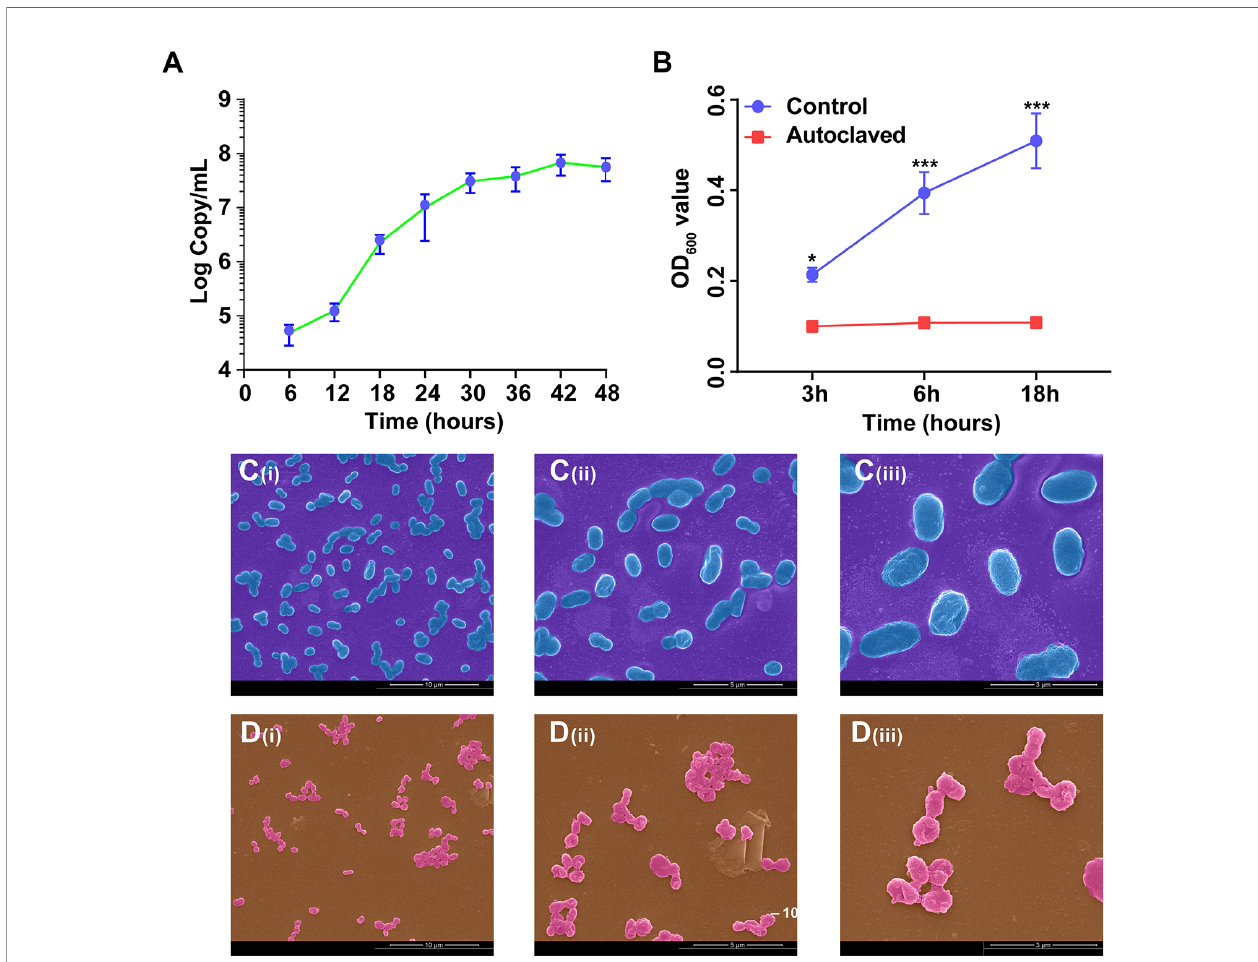
FIGURE 3 | The growth curve and cellular morphology of A. muciniphila . (A) The growth curve of A. muciniphila cultured in BHI medium. (B) The growth curve of A. muciniphila with (Autoclaved) or without (Control) autoclaving in BHI medium within 18 hours. OD 600 value. (C) SEM images of active A. muciniphila . (i) Bar, 10 µm. magni fi cation times, × 5,000. (ii) Bar, 5 µm. magni fi cation times, × 10,000. (iii) Bar, 3 µm. magni fi cation times, × 20,000. (D) SEM images of inactive A. muciniphila . (i) Bar, 10 µm. magni fi cation times, × 5,000. (ii) Bar, 5 µm. magni fi cation times, × 10,000. (iii) Bar, 3 µm. magni fi cation times, × 20,000. Data are expressed as mean ± SEM (n = 3). * P < 0.05, *** P < 0.001. Results represented one of the two independent